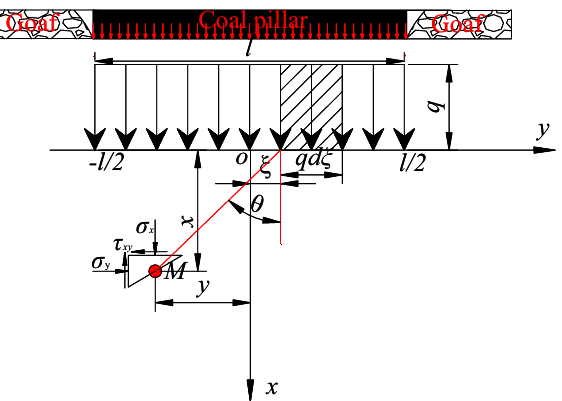
Figure 7. Mechanical calculation diagram of concentrated uniform stress acted to coal pillar floor.